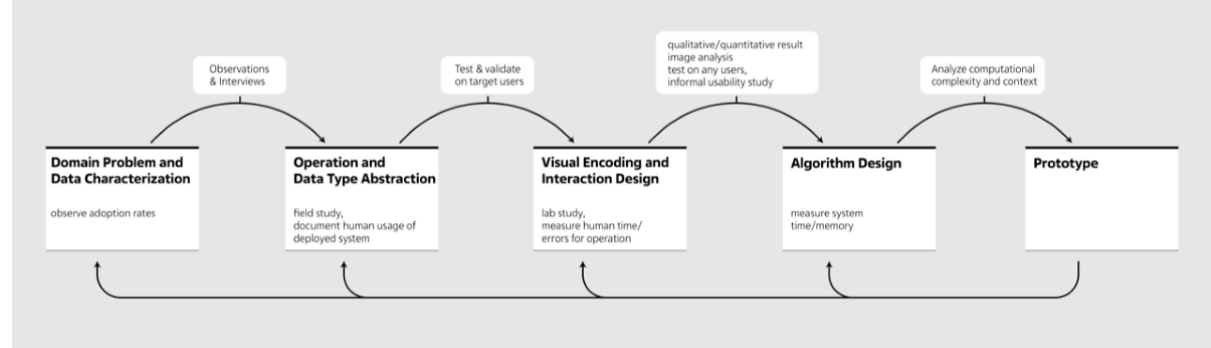
Figure 1. The nested design model, adapted from Munzner [15]. The upper part shows the relevant stages of upstream validation, while the bottom part shows the different dimensions of downstream